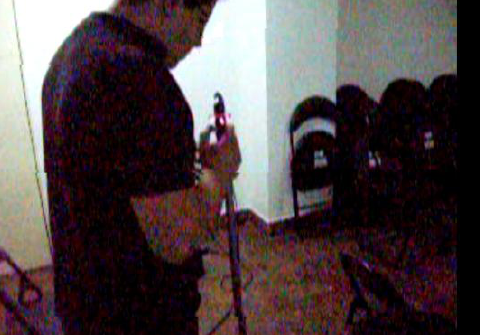
Figure 10. Use of the augmented cane during the evaluation